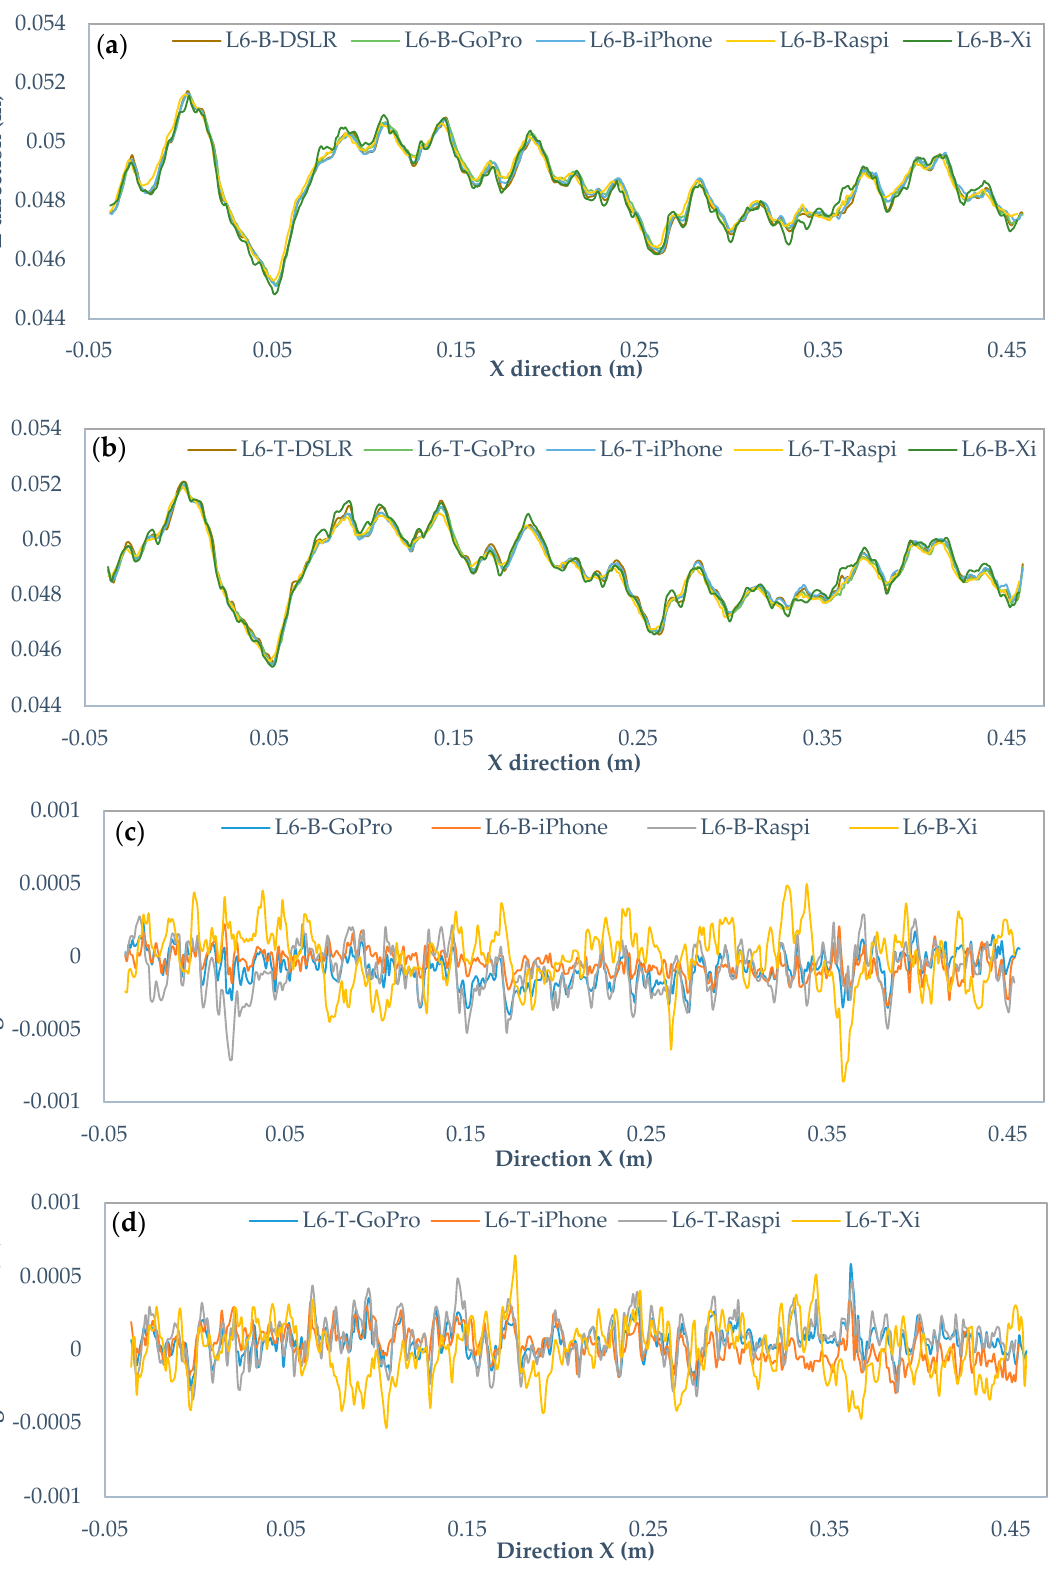
Figure 16. Comparison of the Canon EOS 5DS R DSLR and low-cost cameras profiles with 1 mm rasterization grid interval. ( a ) Original profiles of bottom surface, ( b ) top surface, ( c ) height differences of bottom profiles, and ( d ) top profiles.